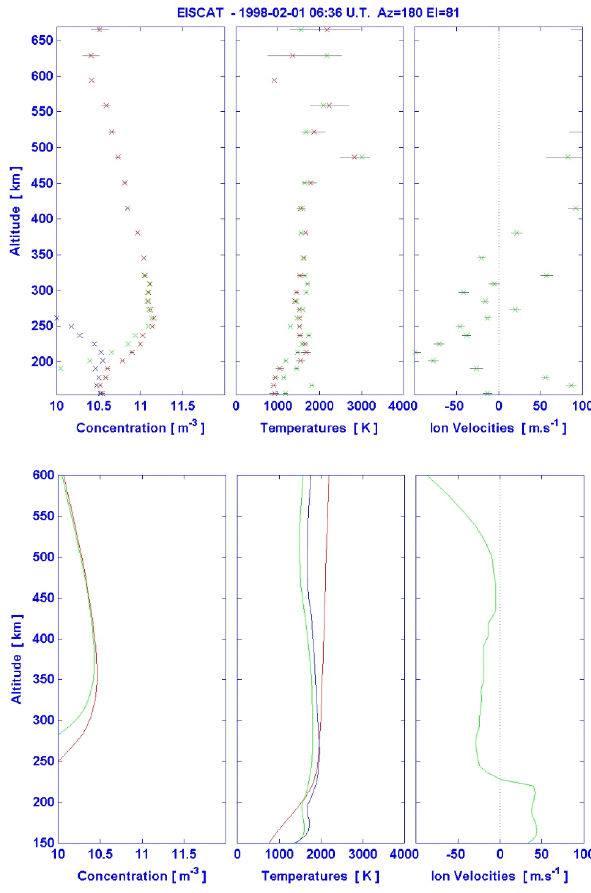
Fig. 9. Measured (top panels) and modelled (bottom) altitude pro- files of the plasma parameters within an electron-heating event (electrons in red, H + in green, molecular ions in blue).